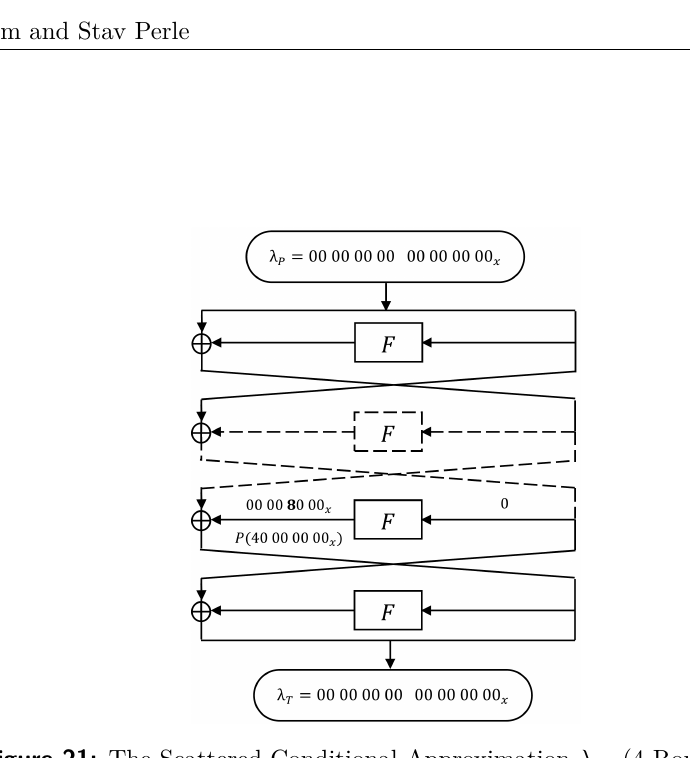
Figure 21: The Scattered Conditional Approximation λ 12 (4 Rounds of 16)